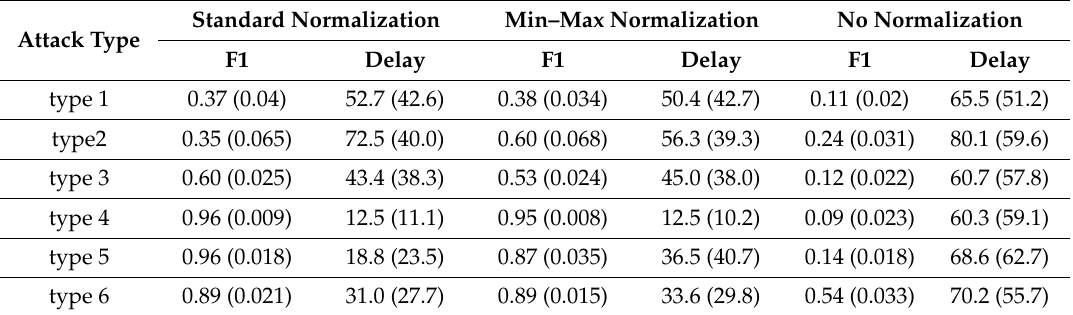
Table 2. The energy theft detection performance when the test data stream was composed of the normal data of one user and the attack data generated from another random user’s data.